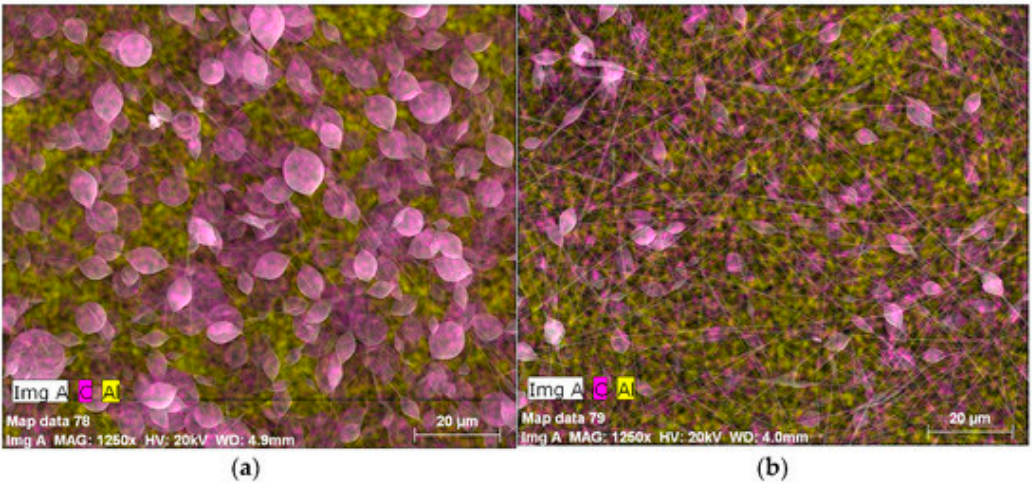
Figure 9. The SEM / EDX mapping micrographs of the as-prepared superhydrophobic coatings of PS / Al 2 O 3 for PA1 sample ( a ) and PA3 sample ( b ). Reprinted with permission of [61].